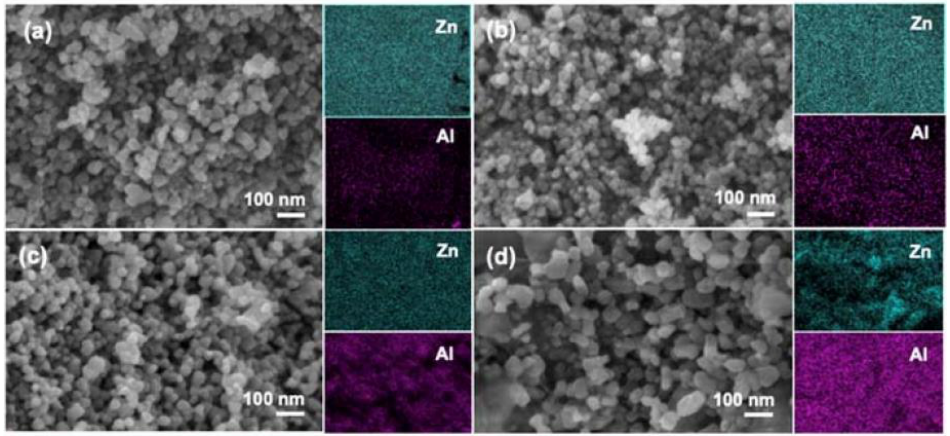
Figure 4. FE-SEM and elemental mapping images of: ( a ) 1% Al/ZnO; ( b ) 3% Al/ZnO; ( c ) 5% Al/ZnO; and ( d ) 10% Al/ZnO photocatalysts.